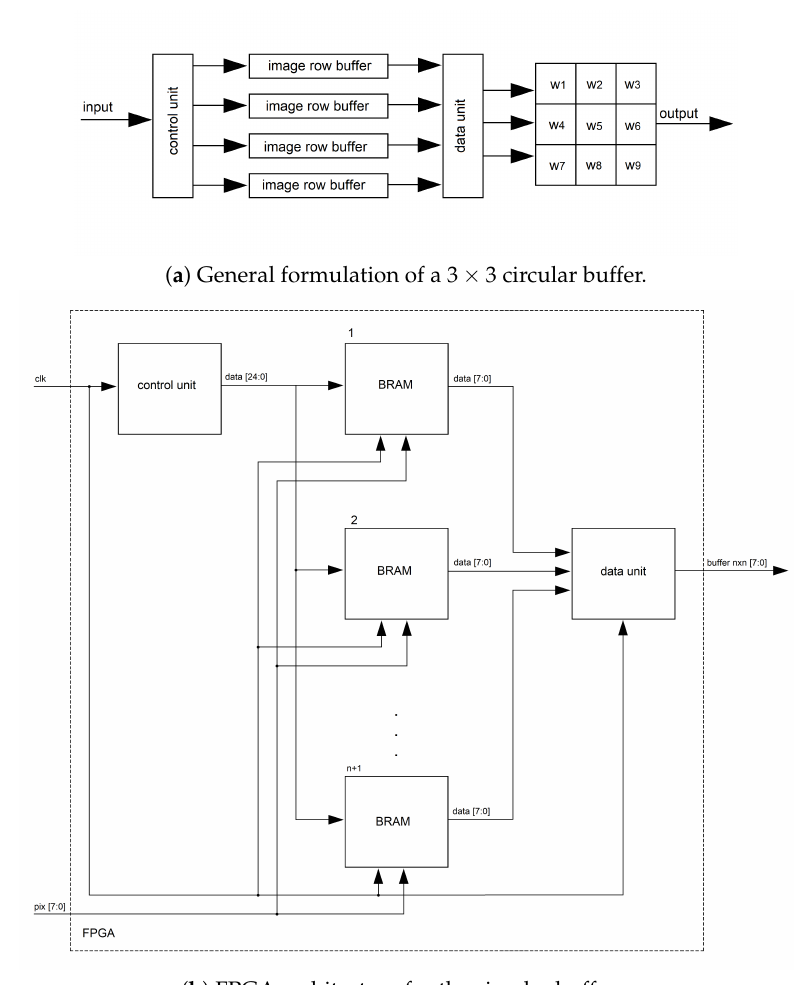
Figure 11. The circular buffers architecture. For an n × n patch, a shift mechanism “control” unit manages the read/write addresses of n + 1 BRAMs. In this formulation, n BRAMs are in read mode, and one BRAM is in write mode in each clock cycle. The n × n buffer then delivers logic registers with all pixels within the patch in